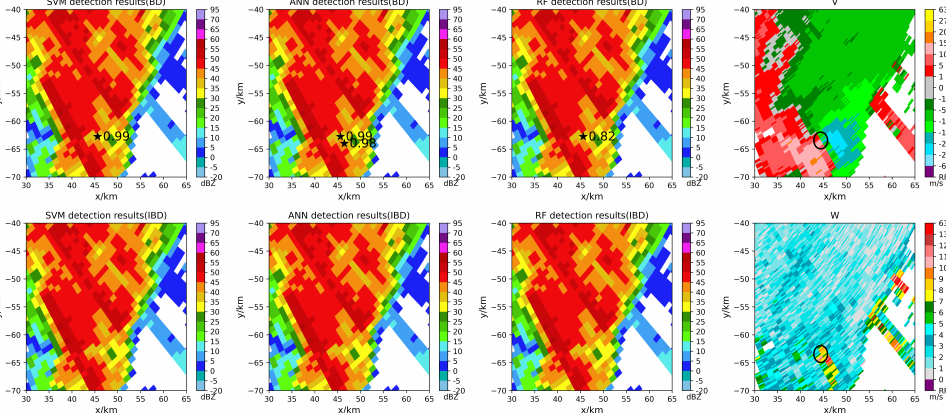
Figure 8. The tornado identification results of models at 11:01 (Beijing time, UTC+8) 0.5-degree (the black circle centered at the tornado location with a radius of 1.5 km, the SVM, ANN, RF represent Support Vector Classifier, Artificial Neural Network Classifier, Random Forest Classifier, the V represents Doppler Velocity, and the W represents Doppler Velocity Spectral Width. The BD indicates that the classifier was formed on a balanced tornado dataset, and the IBD indicates that the classifier was formed on an imbalanced tornado